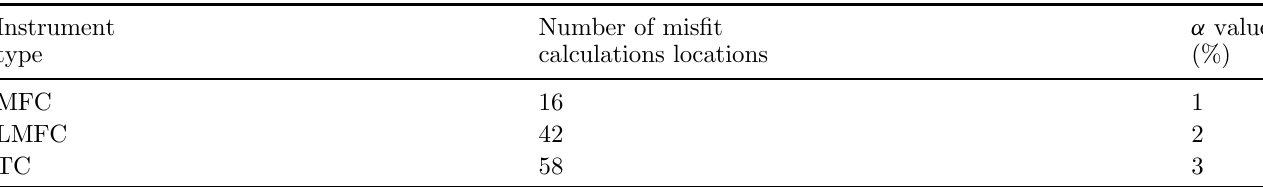
Table 2. Number of mis fi t calculation locations used for each instrument type considered individually for data assimilation, and arbitrary accuracy assumed in the present studies for each type of